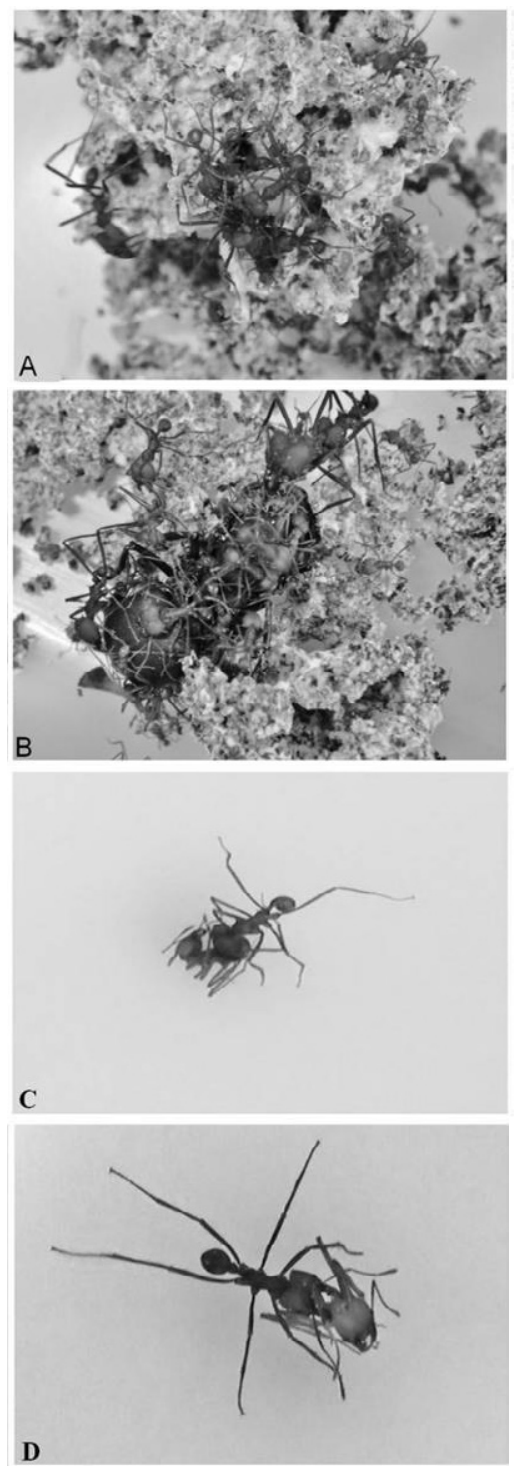
Fig 1 . Behaviors associated to colony defense and social carrying during colony emigration, in A. sexdens . A, B : Aggregation of median and major workers around the body surface of larvae (A), and queen (B). C, D : Social carrying behavior of a newly-emerged worker during colony